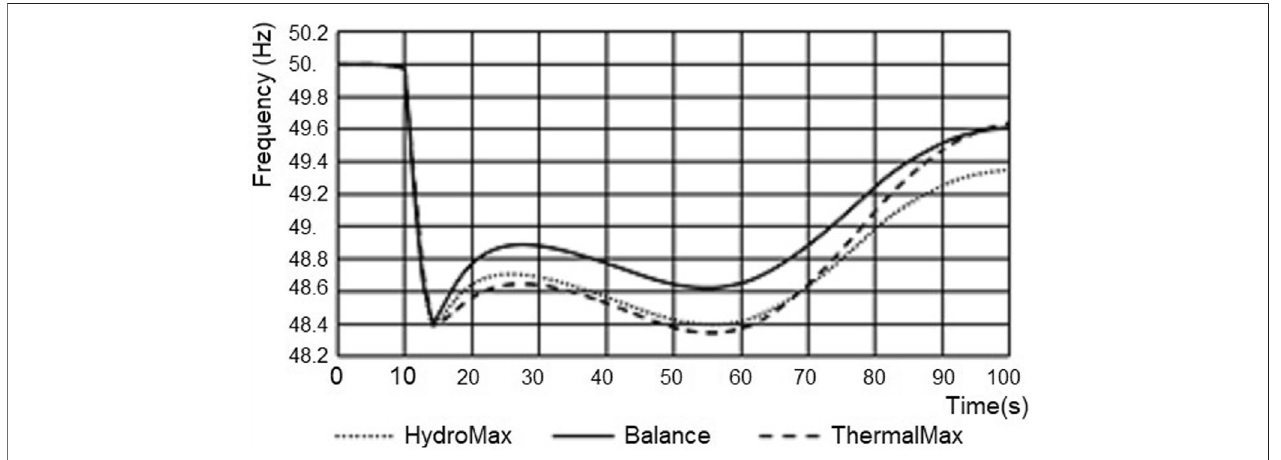
FIGURE 2 | Dynamic frequency response when thermal and hydro generation is at their